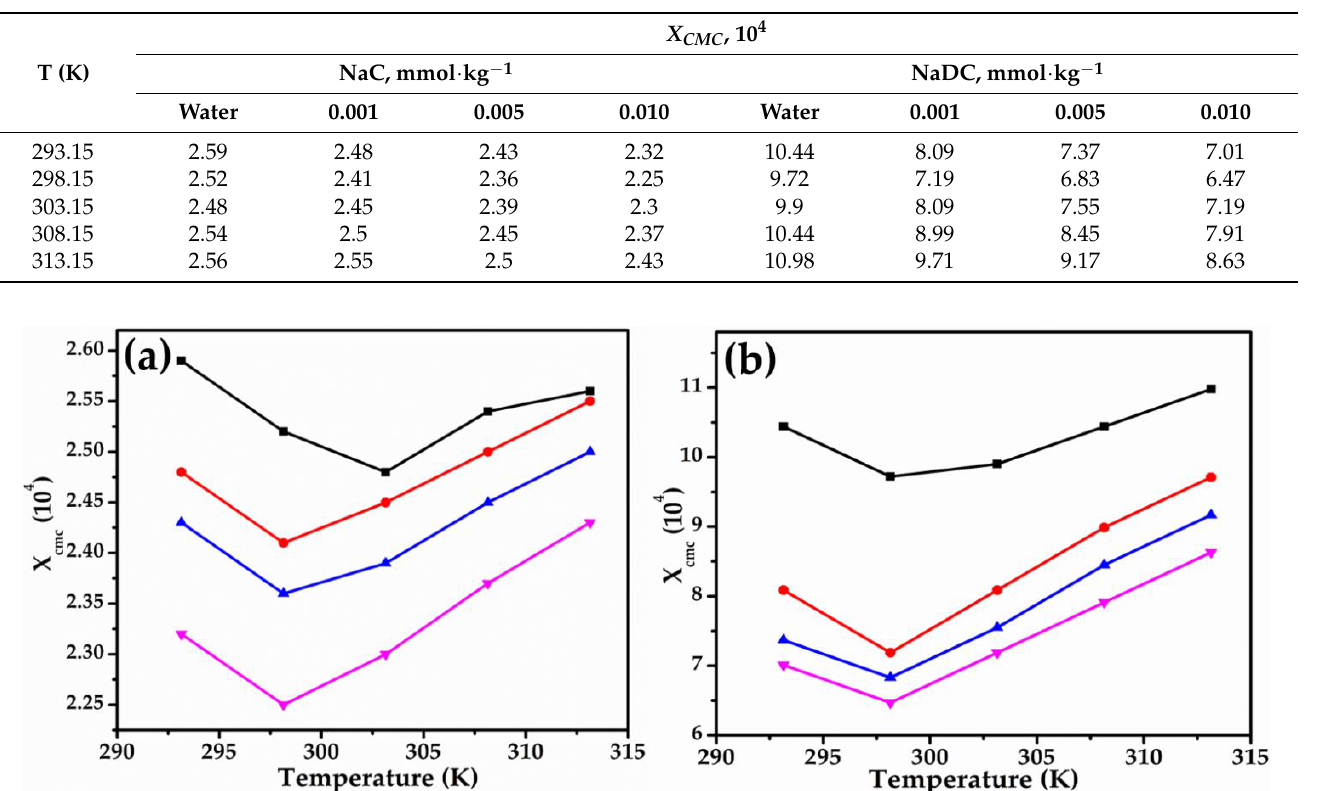
Figure 3. Illustrative plots of C M C X vs. temperature for ( a ) NaC and ( b ) NaDC in water ( ■ ), and 0.001 (●) , 0.005 ( ▲ ) and 0.010 ( ▼ ) mol∙kg − 1 aqueous glycyl dipeptide.